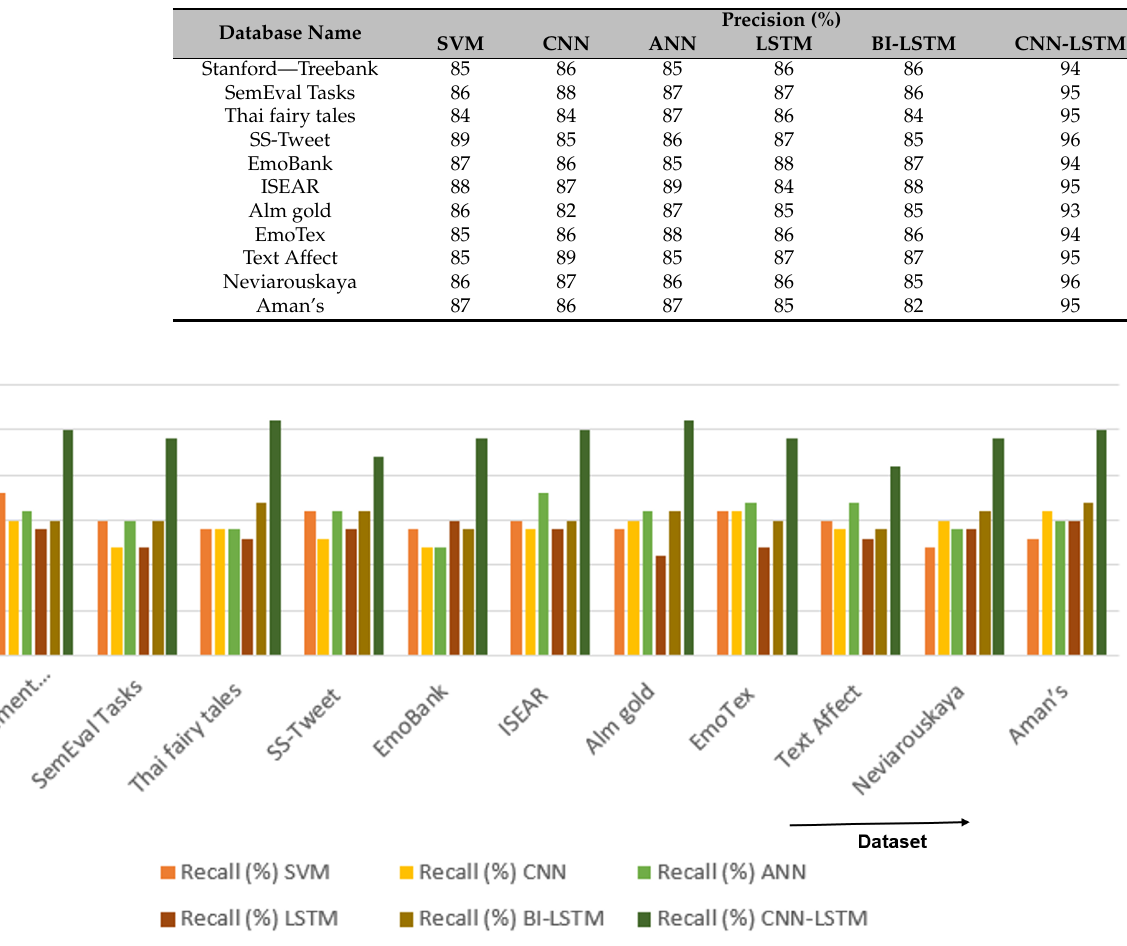
Table 5. Performance analysis for BOW + IF-IDF with CNN-LSTM based on precision.